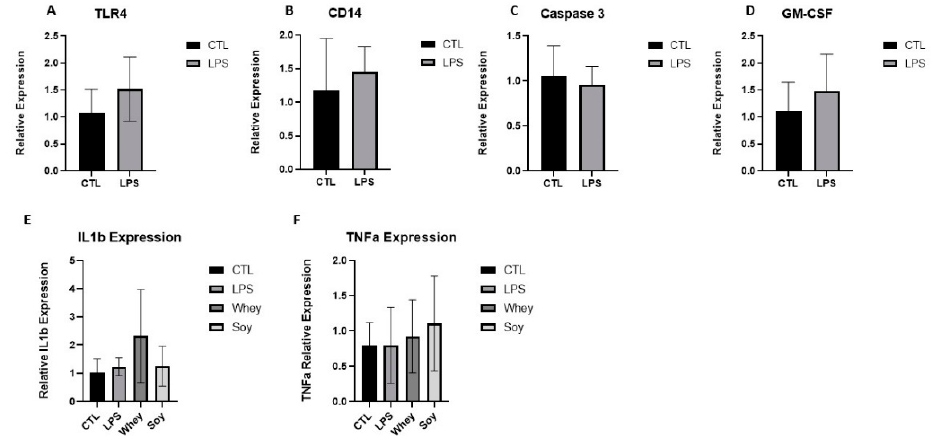
Figure 4. The effect of LPS and study diets on ( A ) TLR4, ( B ) CD14, ( C ) Caspase 3, ( D ) GM-CSF, ( E ) IL-1 β , and ( F ) TNF α expression in rat spleens. ( A – D ) Student’s t -Test was used, ( E , F ) ANOVA was used. Mean ± SD values are shown.